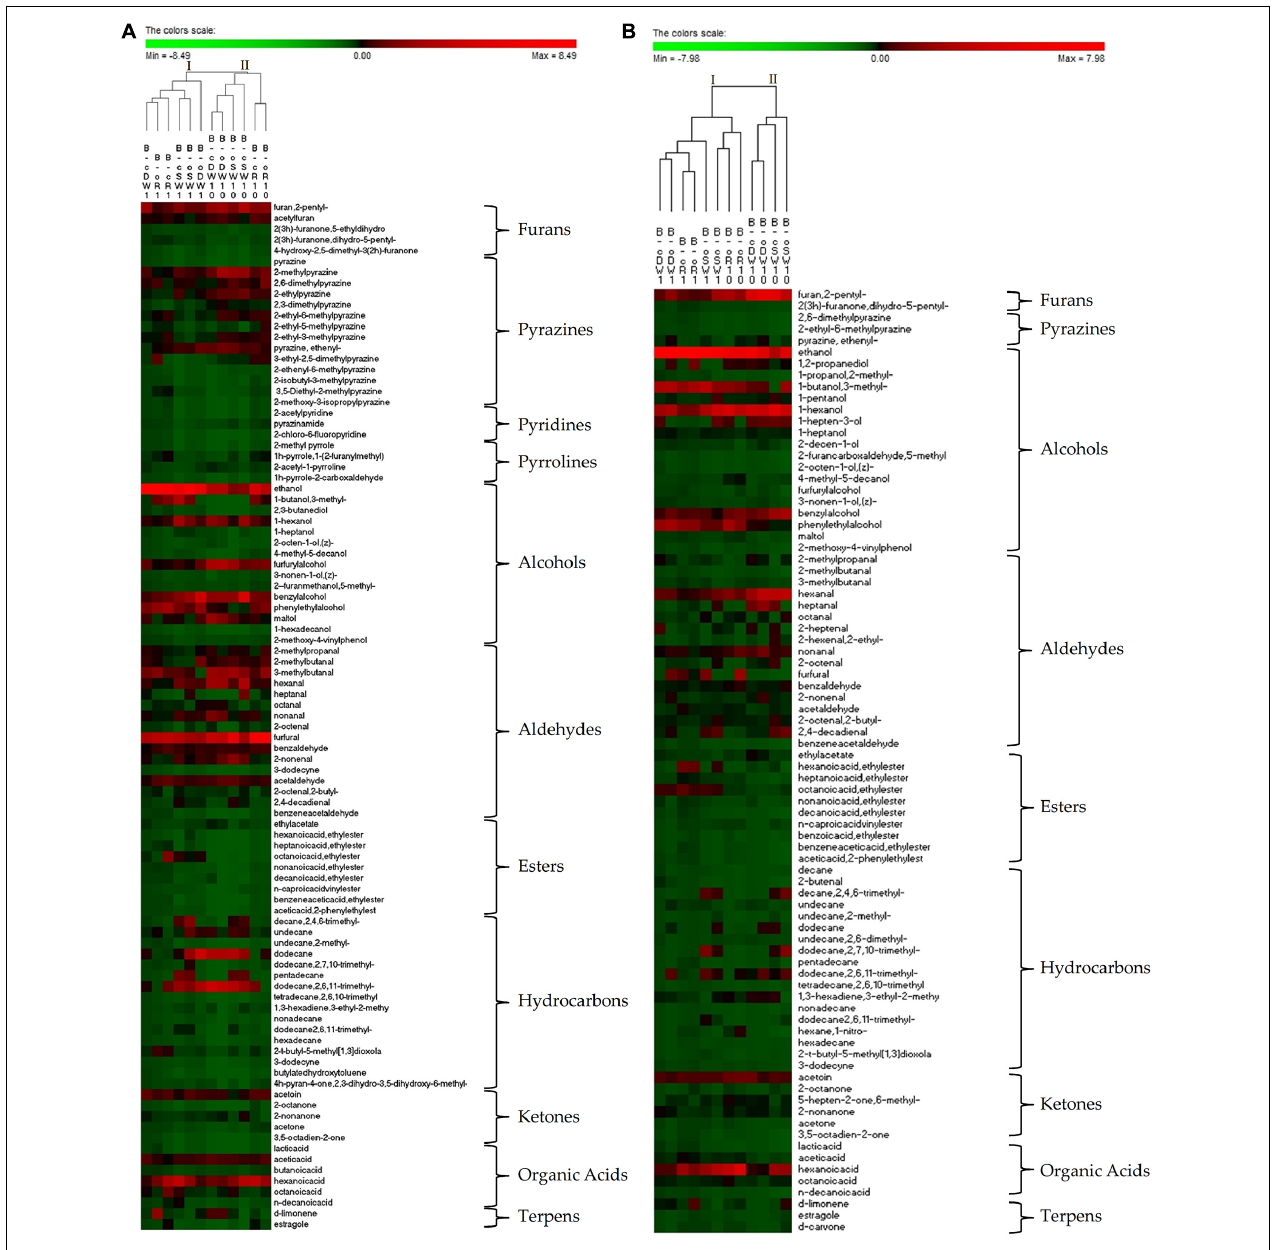
FIGURE 4 | Permutation matrix of the relative abundances of the organic volatile compound identified in the crust (A) and crumb (B) of breads prepared with the sourdoughs obtained after the first fermentation (B-cR1, B-oR1, B-cDW1, B-oDW1, B-cSW1, and B-oSW1) and those after 10 days of propagation (B-cR10, B-oR10, B-cDW10, B-oDW10, B-cSW10, and B-oSW10). The sourdoughs were used as leavening agent at 15% and 40% (w/w) in wheat (DY, 160) and rye (DY, 180) breads, respectively. Lactiplantibacillus plantarum oR4 and DW9 strains were used as binary starters in association with Pediococcus acidilactici oSW5